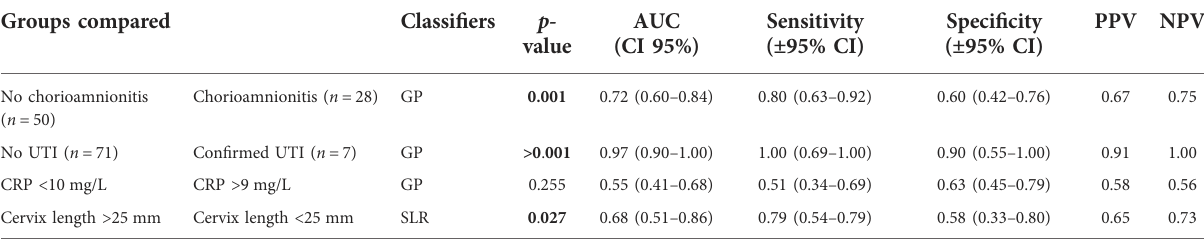
TABLE 3 GC-IMS results for the post-hoc analysis. Groups